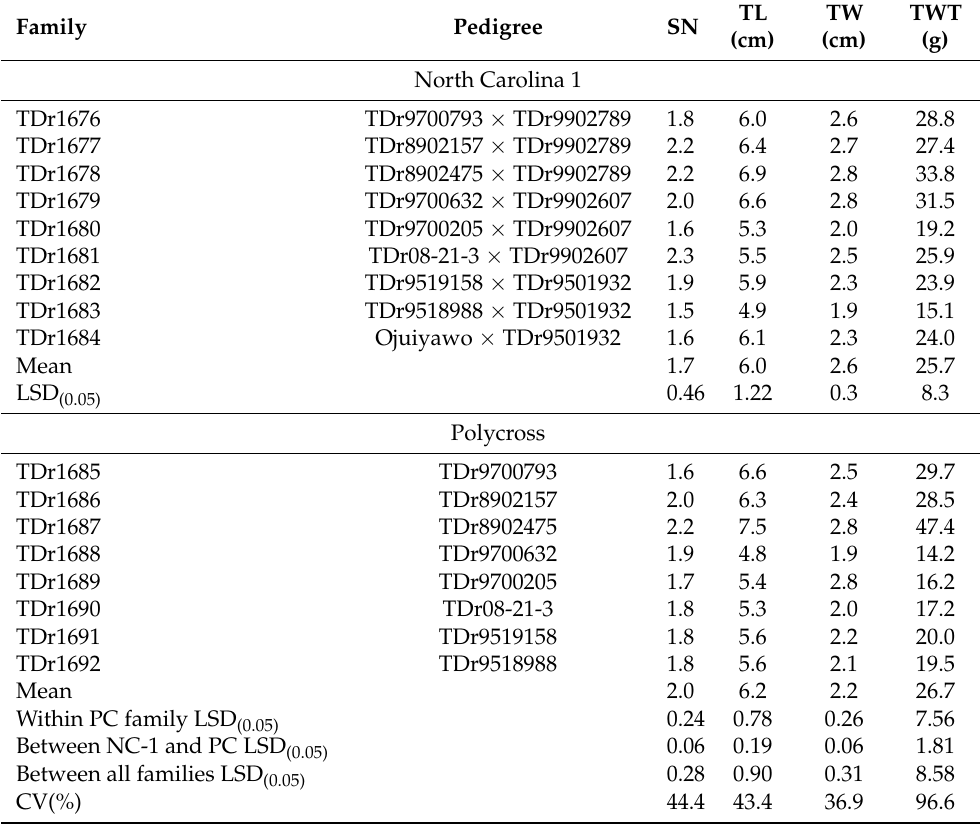
Table 4. Mean seedling traits of first filial generation yam populations developed using North Carolina 1 and polycross